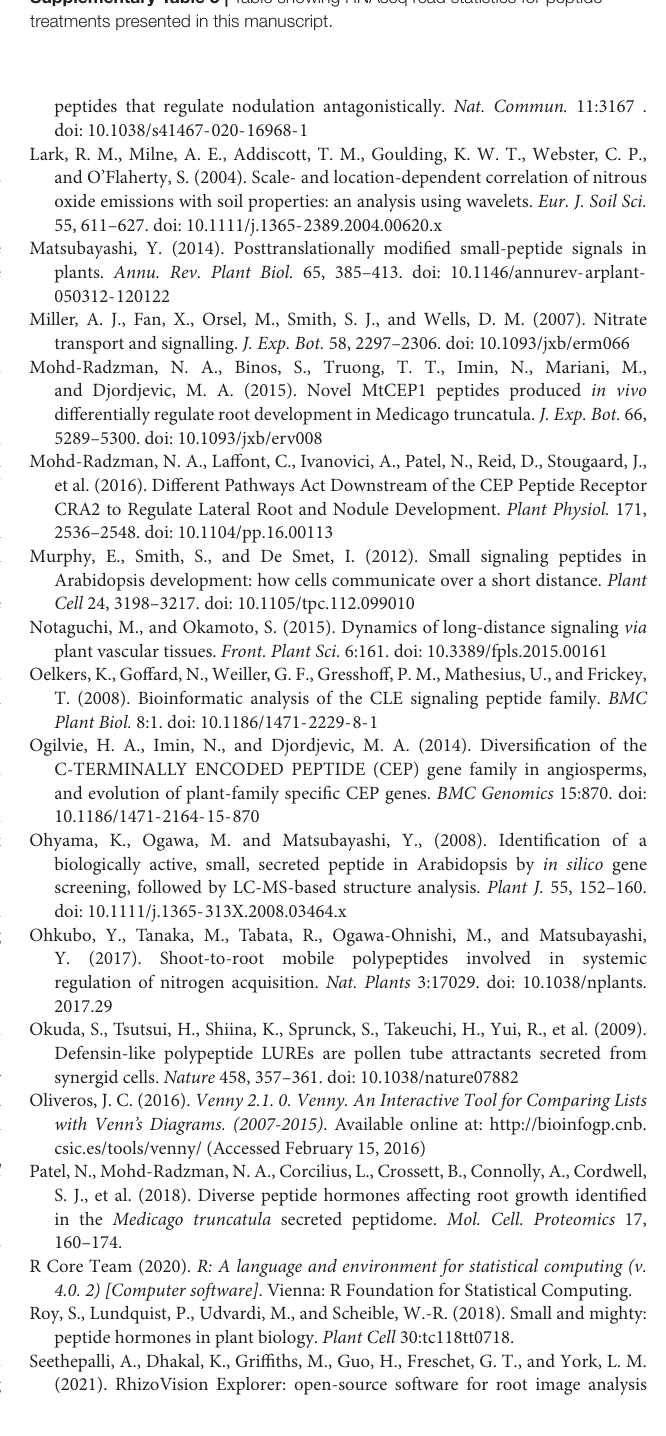
Supplementary Figure 4 | Principal component analysis graph showing distribution of biological replicates in peptide treated and control samples. Plot was generated using DESeq2 using a read count filter of 30 and a Median Ratio Normalization. Green dots represent the Control (CEP1C), blue dots represent CEP1D1, purple dots represent CEP1D2, and red dots represent AtCEP1 treatment. Supplementary Table 1 | Transcript per million (TPM) counts, DESeq2 results and differentially expressed genes under MtCEP1D1, MtCEP1D2, and AtCEP1 application.